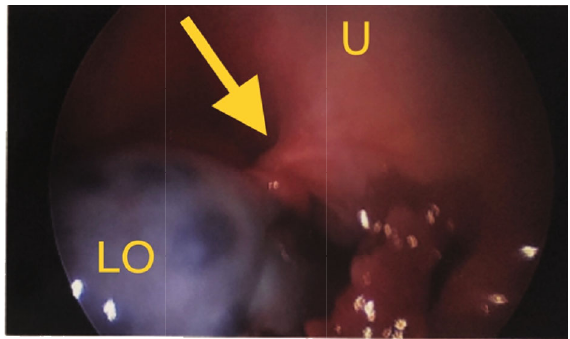
Figure 4: Intraoperative view of the uterus (U), left ovary (LO) with bluish hue and twisted utero-ovarian ligament (yellow arrow).